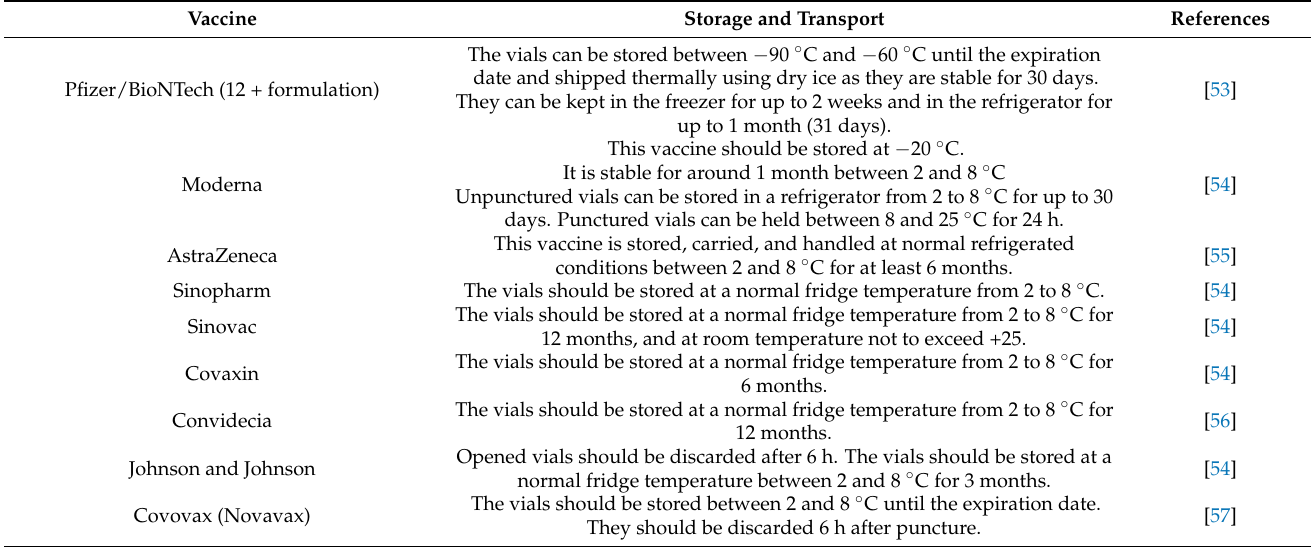
Table 2. Storage and transport of COVID-19